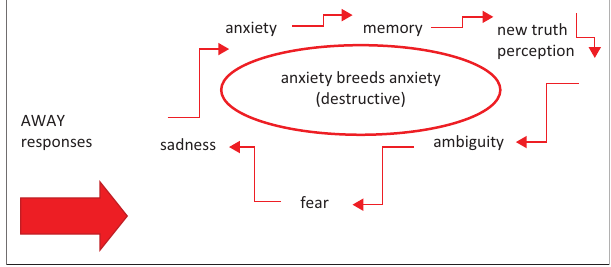
FIGURE 3: The individual’s away responses as reactions to